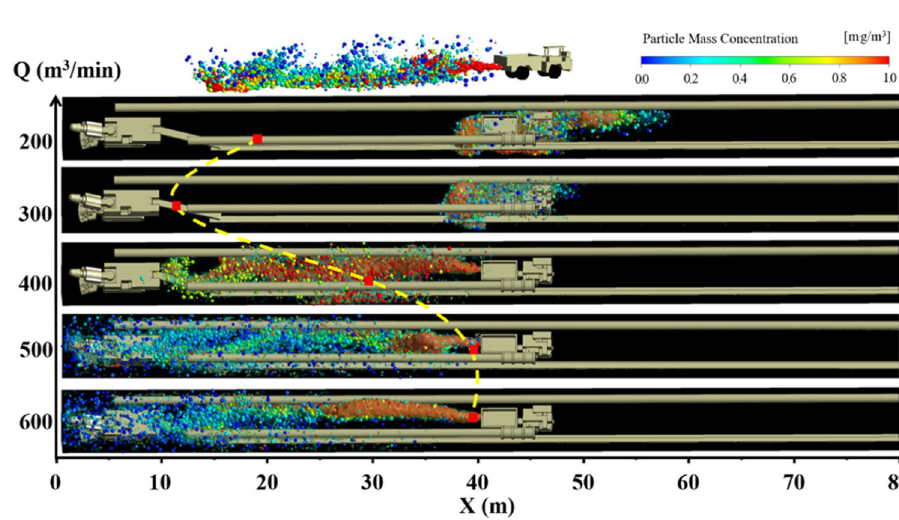
Figure 11. DPM distribution under different air volumes Q at L = 40